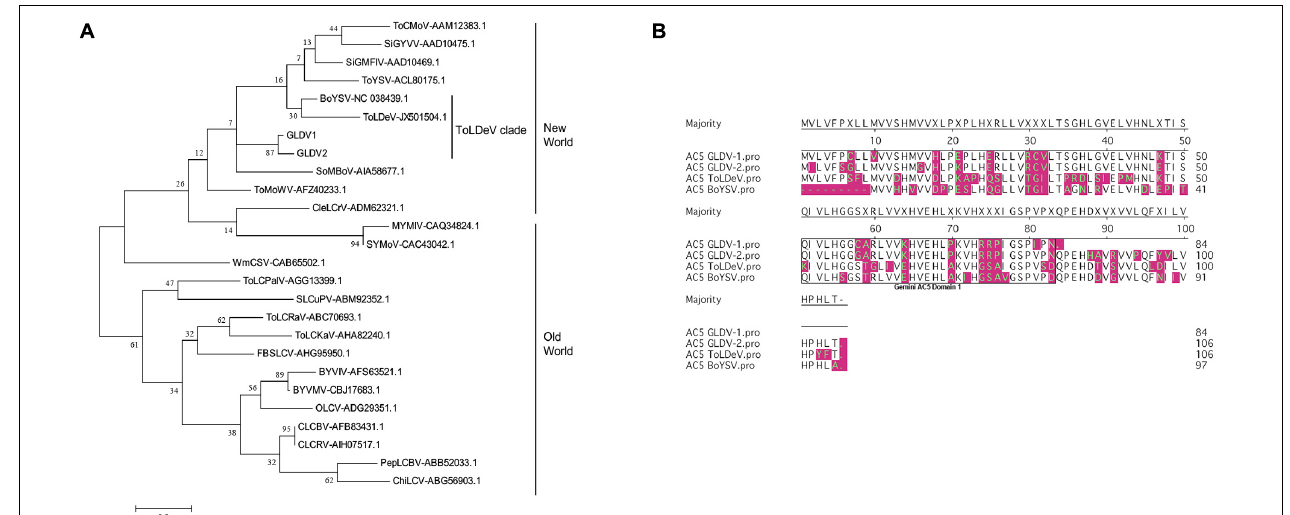
FIGURE 5 | Phylogenetic and amino acid analysis of Galium leaf distortion virus (GLDV) isolates AC5 proteins. (A) Maximum likelihood (ML) unrooted phylogenetic tree based on nucleotide sequences of AC5 coding regions. ML phylogenies were constructed by multiple alignments of GLDV isolates open reading frames (ORFs) of AC5 gene, and 24 selected AC5 sequences representative of new world (NW) and old world (OW) begomoviruses. ML method in MEGA 7 was based on the Tamura-Nei model and the tree support was tested by bootstrapping with 1,000 replicates. The scale bar represents the genetic distance. The division of NW, OW, and ToLDeV clades is indicated. Accession numbers of viral isolates are shown. Begomovirus acronyms are summarized in Supplementary Table 1 . (B) Alignment of AC5 amino acid sequences of viruses belonging to ToLDeV clade. Differential amino acid residues are highlighted in magenta. Gemini AC5 Domain 1 was identified using the conserved domain database